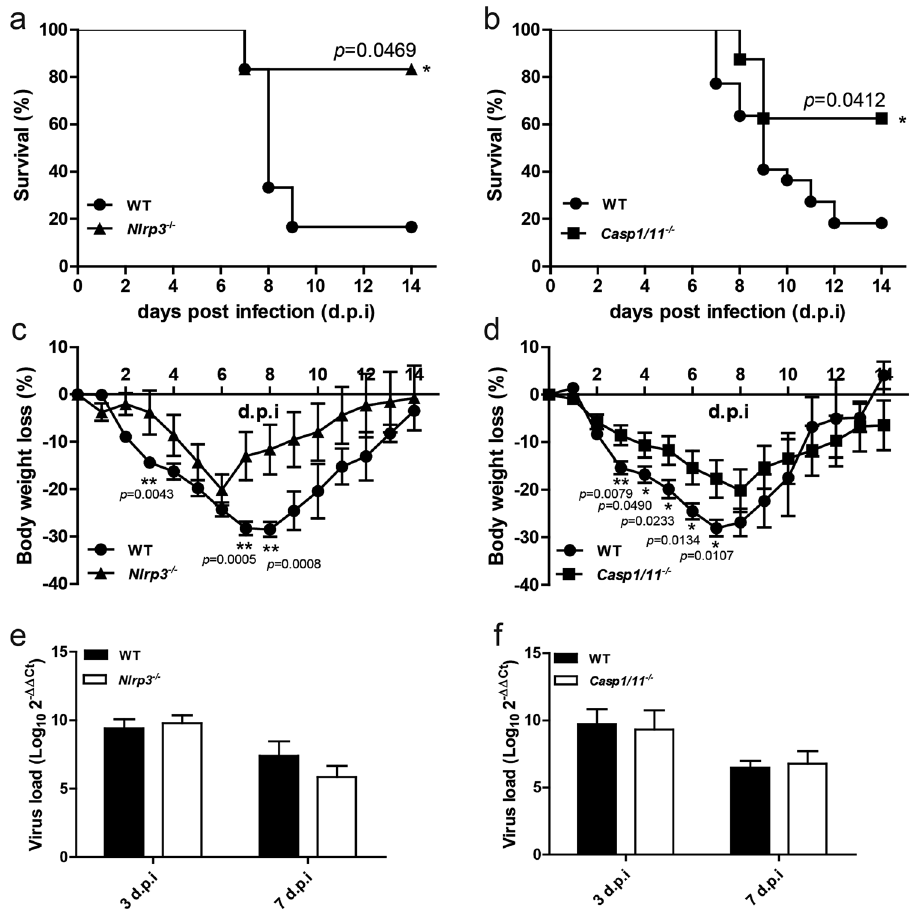
Figure 2. Deficiency of NLRP3 or caspase-1 protects mice against H7N9 infection. ( a ) Wild-type (WT) (n = 18), Nlrp3 − / − (n = 18), ( b ) WT (n = 22), C asp1/11 − / − (n = 20) mice were infected intranasally with 5 × 10 4 TCID 50 of H7N9 virus, and survival was monitored daily for 14 days. * P < 0.05, Log-rank (Mantel-Cox) test. ( c , d ) The percentages of weight loss of WT, Nlrp3 − / − and Caspase1/11 − / − were measured during 14 days. ( e,f ) WT, Nlrp3 − / − and Casp1/11 − / − mice were infected as in ( a , b ) and the lungs were harvested at 3,7 days post infection (d.p.i), each group contained 3 mice, viral load were determined via real time PCR, values represent the mean of triplicate samples ± SD. Data are pooled from three independent infection experiments. ** P < 0.01, * P <